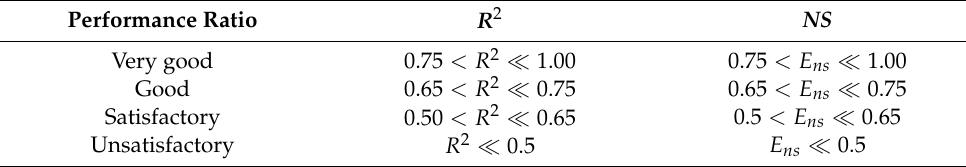
Figure 8. Comparison of total nitrogen concentration determination and validation. Figure 9. Comparison of total phosphorus concentration determination and validation.